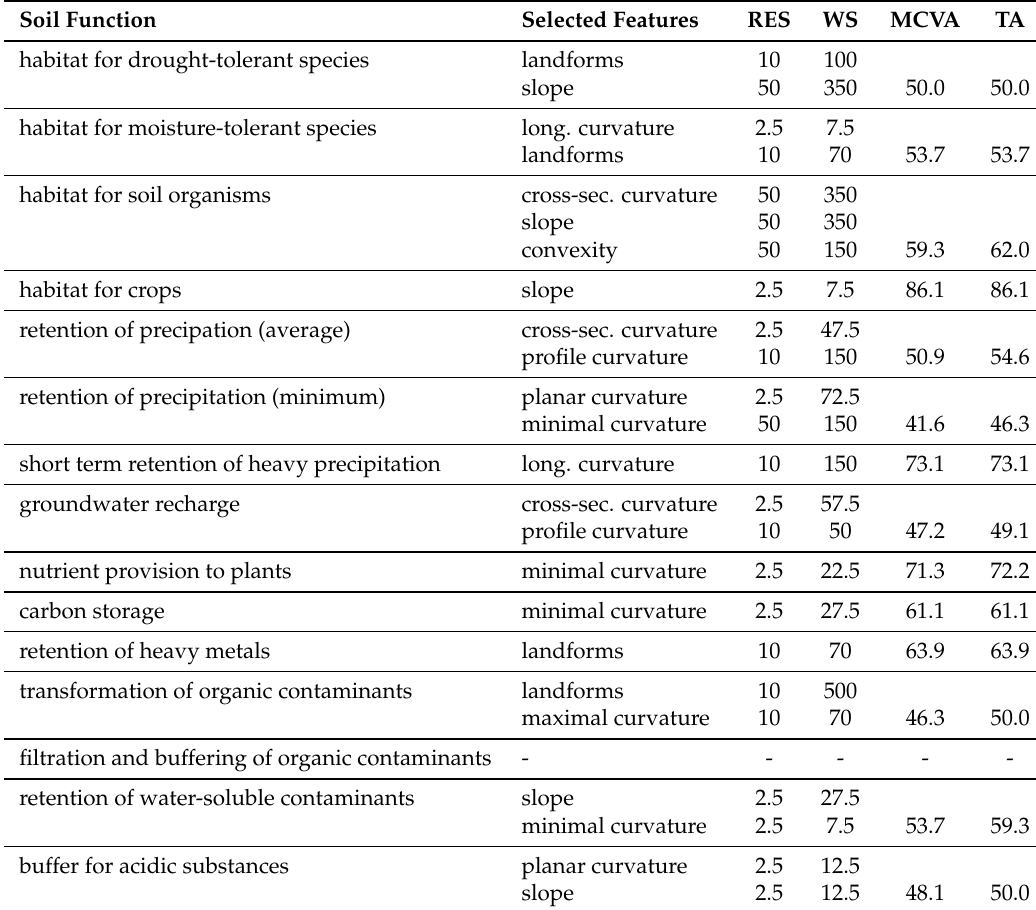
Table 4. Results of the feature selection and validation. RES = resolution [m] of the applied digital terrain model, WS = window size [m] of computational algorithm, MCVA = median cross-validated